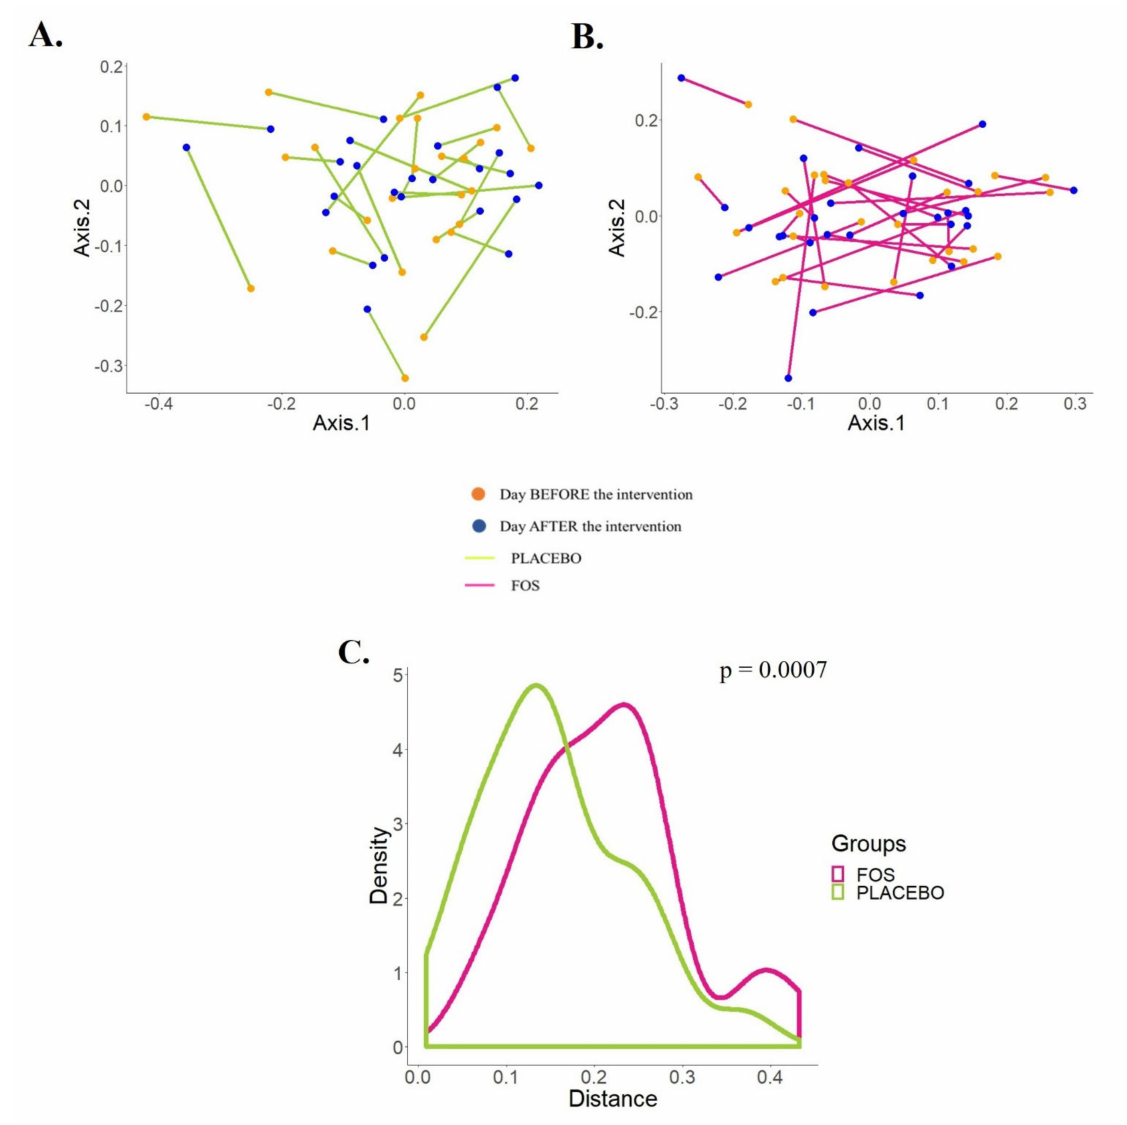
Figure 3. E ff ects of the supplementation with placebo or fructooligosaccharide (FOS) on the human milk microbiota of each subject. ( A , B ) PCoA plots of Jensen–Shannon distance (JSD) shows the e ff ects of the maternal supplementation with placebo ( A ) or FOS ( B ) on the phylogenetic structures of the human milk microbiota. ( C ) Distribution of the distances (JSD) between “before” and “after” supplementation for each subject by group shows statistically significant di ff erences between the placebo and the FOS group (Mann–Whitney